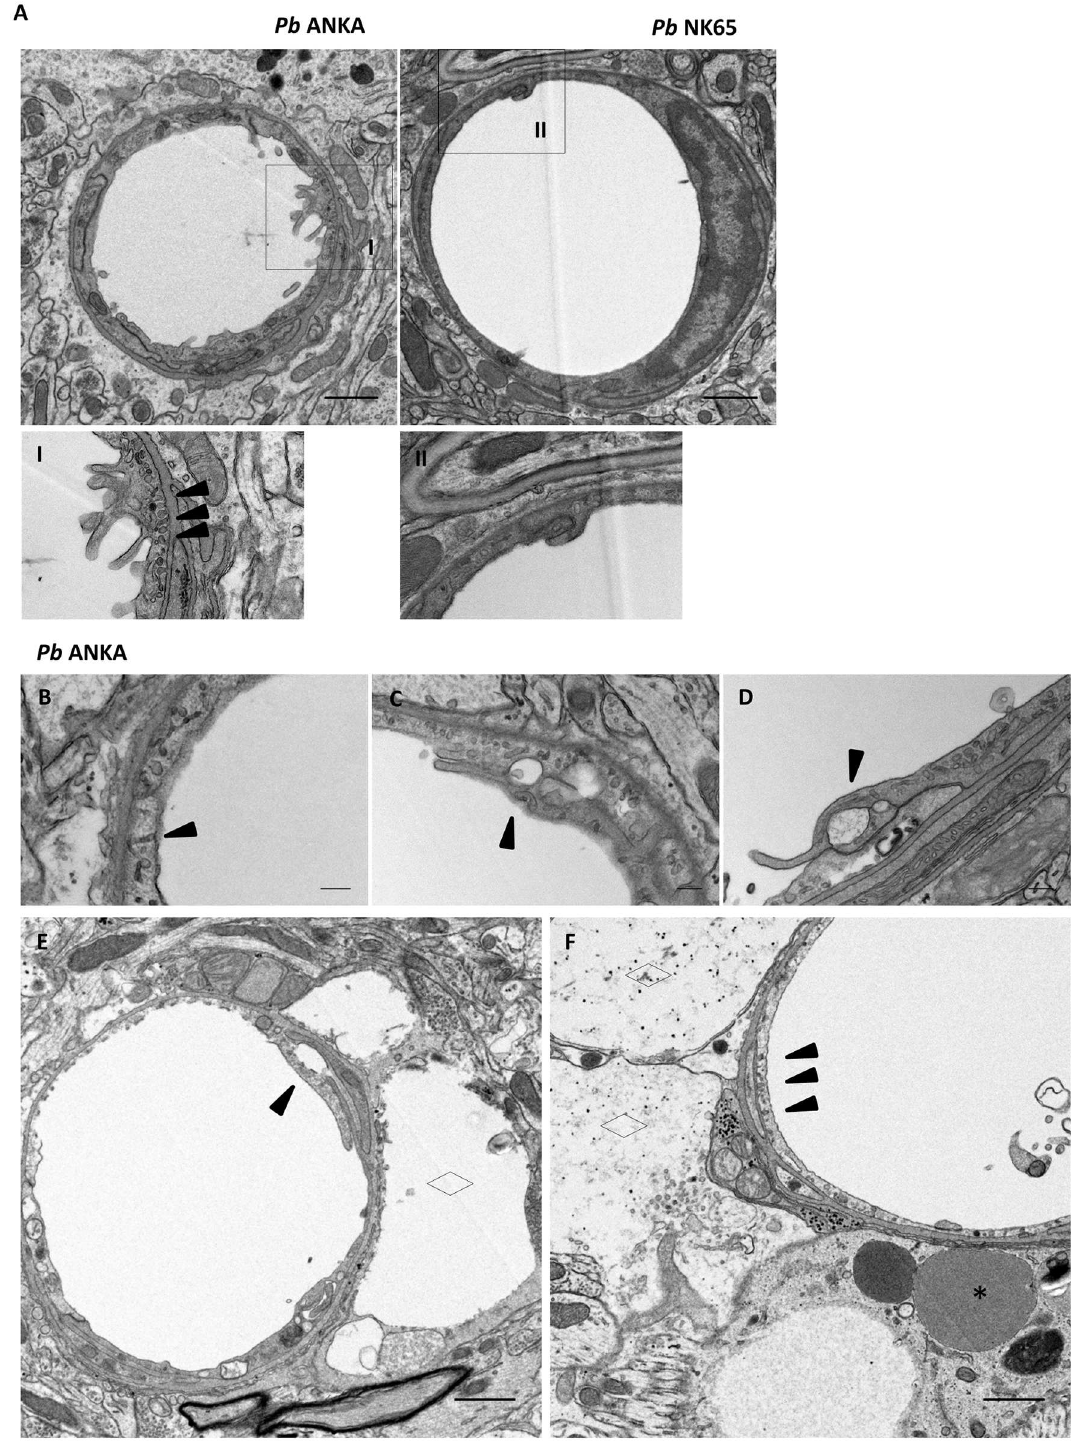
Fig 8. Vascular leakage is associated with dysregulation of transcellular and paracellular transport mechanisms during ECM. C57BL/6mice were infected with 1x10 4 Pb ANKA GFP (n = 3) or 1x10 4 Pb NK65 GFP (n = 3) pRBCs. Mice were culled at d7 p.i when Pb ANKA infected mice exhibitedsigns of late-stage ECM. Brains were removedfrom transcardiallyperfused mice and processedfor TEM (A) Electron micrographs of representative vessels from Pb ANKA and Pb NK65 infected mice. Note the thickenedendotheliumand narrowedlumen consistent with vasospasm,